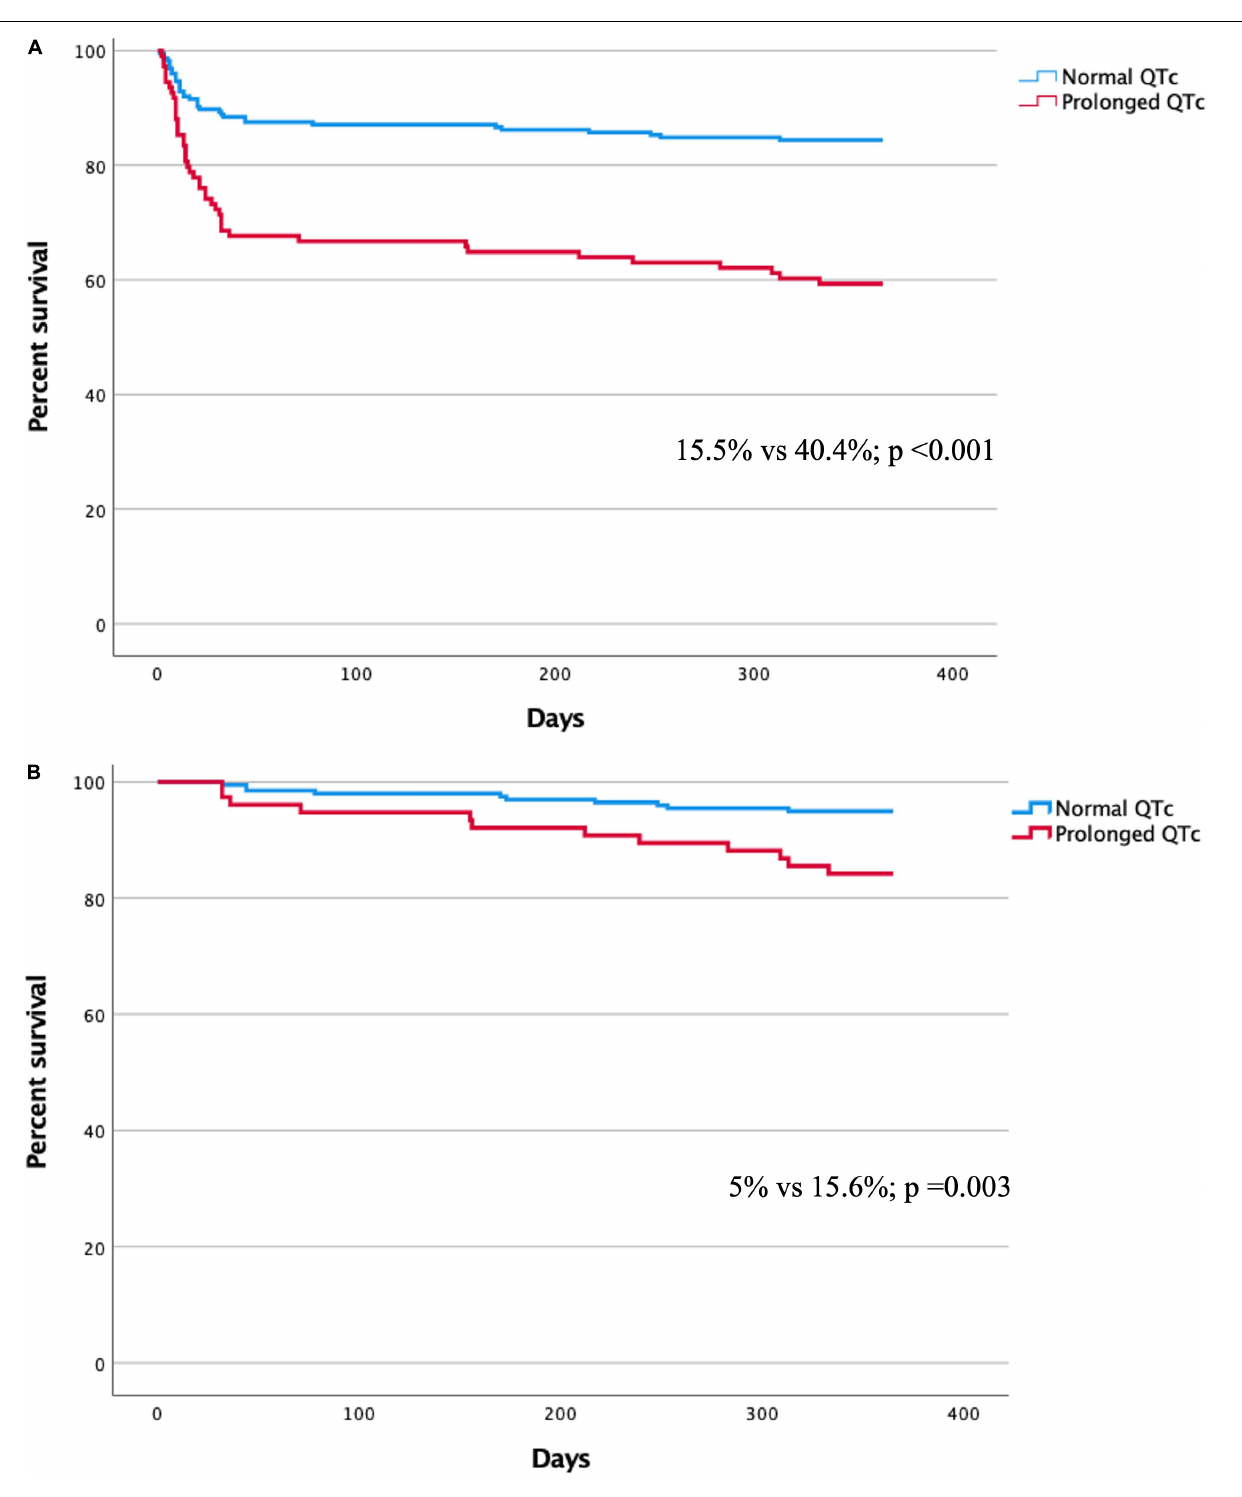
FIGURE 2 | (A) Kaplan-Meier curve for 1-year mortality in patients with and without QTc prolongation. (B) Kaplan-Meier curve for 1-year mortality among 30-day survivors in patients with and without QTc prolongation.